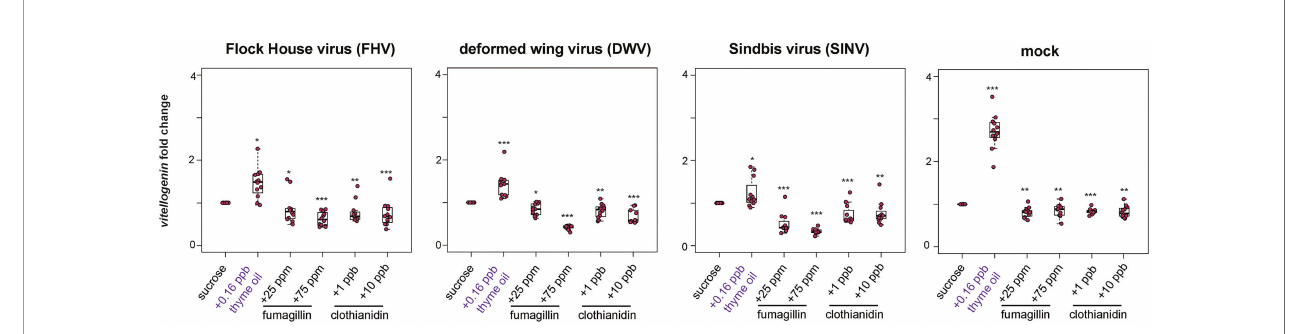
FIGURE 6 | Vitellogenin expression was higher in bees fed sucrose syrup containing thyme oil and lower in bees fed sucrose syrup containing fumagillin or clothianidin. Vitellogenin expression was assessed using qPCR and the relative gene expression was analyzed using the DD Ct method with normalization to rpl8 and relative to expression in mock or virus-infected bees fed sucrose syrup only. In virus-infected (i.e., FHV, DWV, SINV) and mock-infected honey bees vitellogenin expression was greater in bees fed sucrose syrup containing thyme oil and reduced in bees fed sucrose syrup containing fumagillin (25 ppm or 75 ppm) or clothianidin (1 ppb or 10 ppb) relative to sucrose only fed bees. Asterisks indicate a signi fi cant change in gene expression compared to sucrose only control; signi fi cance levels: * p < 0.05; ** p < 0.005; *** p < 0.0005. This fi gure shows representative biological replicate for vitellogenin expression. The data for one additional biological replicate is presented in Supplemental Figure S9 . Raw data are included in Supplemental Tables S21 , S22